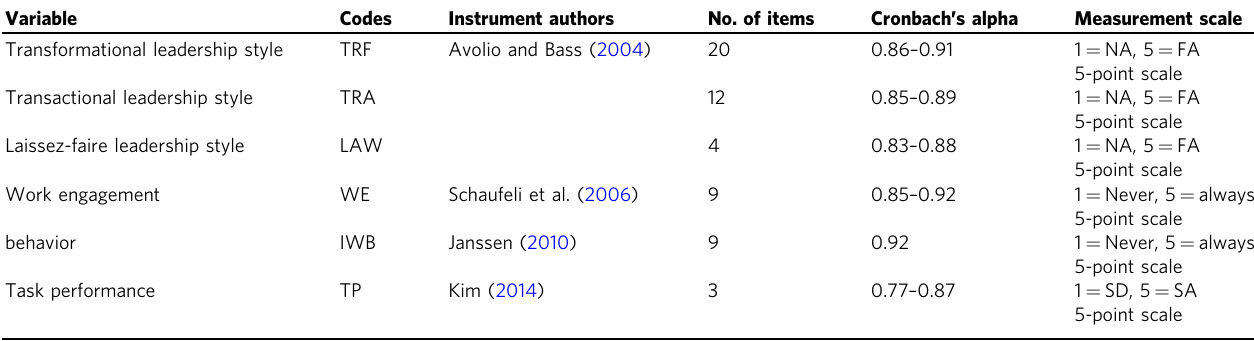
Table 2 Questionnaire design.